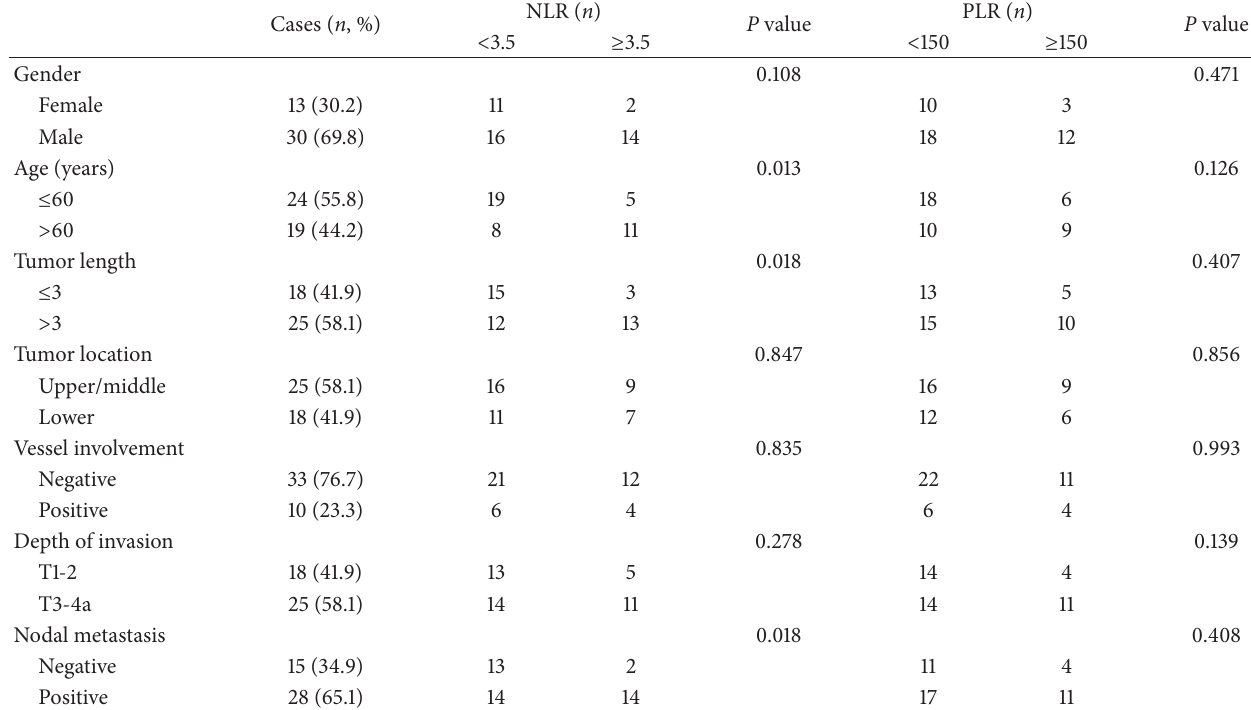
Table 1: The characteristics of the 43 SCCE patients grouped by NLR and PLR.